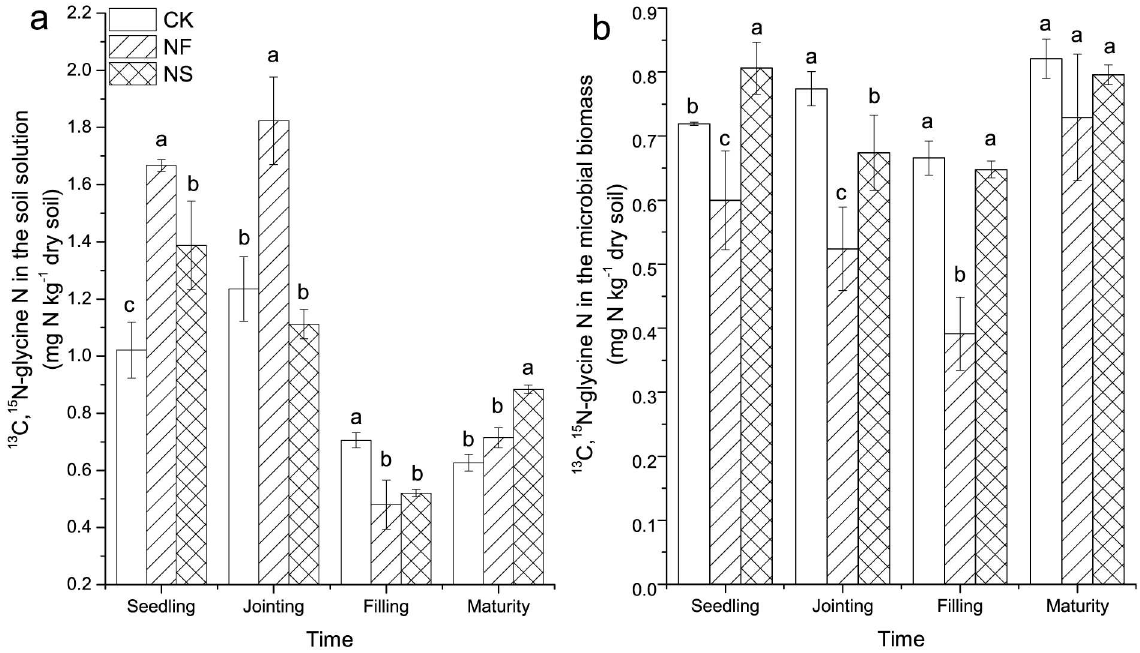
Fig 4. The amount of added 13 C, 15 N-glycine in soil solution and in the microbial biomass under different treatments and different sampling times. Data points represent the mean of four replicates at each samplingtime and error bars are the standard deviationof the mean. Different lowercaseletters indicate significantdifferences betweentreatments at P < 0.05.Different capital letters indicate significantdifferences amongsamplingtimes for the same treatment at P < 0.05. The three treatments are: CK, control; NF, (NH 4 ) 2 SO 4 ; NS, (NH 4 ) 2 SO 4 + rice